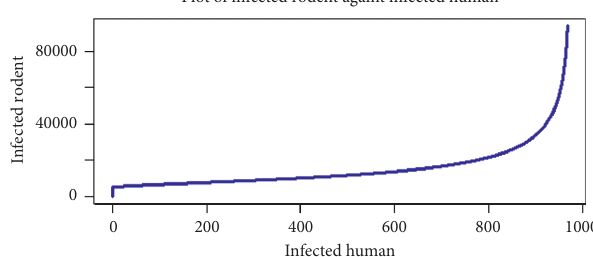
Figure 5: Phase plane for infected mastomys rodent against in- fected